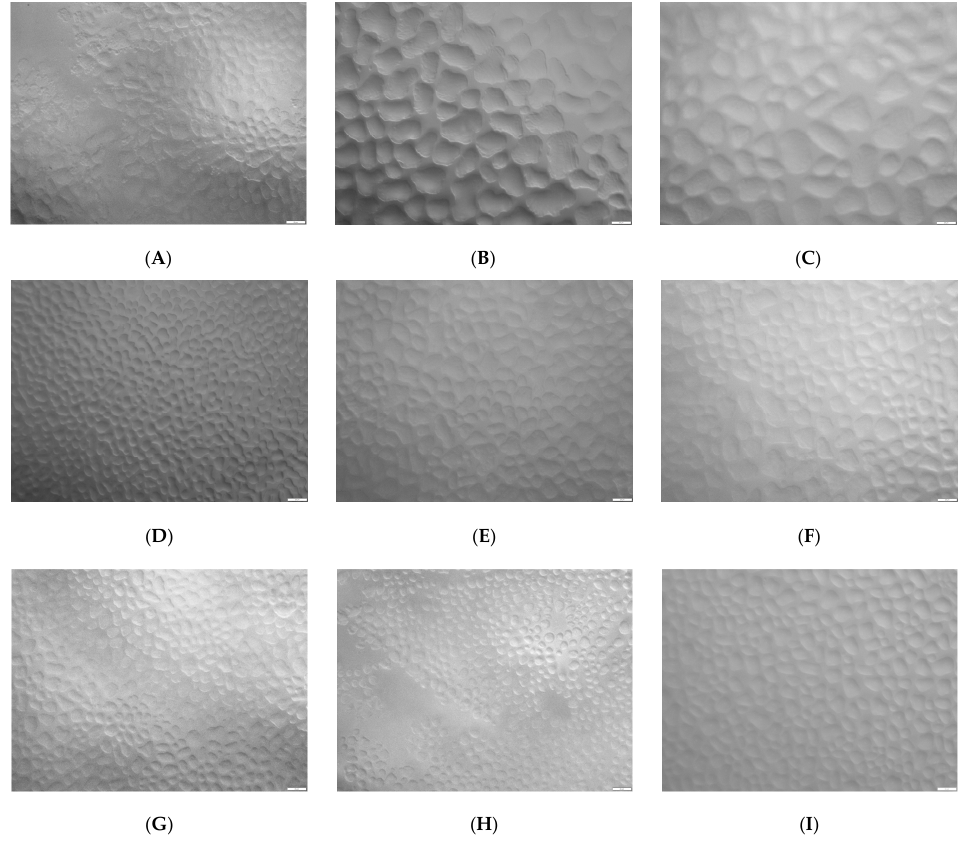
Figure 6. Microscopic images of ice crystals in low ‐ fat milky ice cream with and without stabilizers after different times of storage (( A , D , G ) 24 h, ( B , E , H ) 1 week (1 W) and ( C , F , I ) 1 month (1 M)): ( A – C ) low ‐ fat milky ice cream without stabilizer (control); ( D – F ) low ‐ fat milky ice cream with 0.5% of Cremodan ® SI 320; ( G – I ) low ‐ fat milky ice cream with 0.5% of oat β‐ glucan. Small ice crystals ranging in size to 20 μ m of equivalent diameter give the product desired smoothness, while ice crystals larger than 50 μ m give the product an undesirable lumpy texture [6,7,39,40]. Probably milk protein with the combination of β‐ glucan creates the favorable structure with the best water ‐ holding capacity resulting in better crystal structure creation. The β‐ glucan addition probably also changes the heating exchange con ‐ ditions during ice cream production, which was also visible in the lower value of cryo ‐ scopic temperature in comparison to the cryoscopic temperature of the control sample (Table 3). Similar correlation was already shown for the ice cream stabilizer’s addition [41]. It was also proved that a polysaccharide addition could lead to growth of the crystals different from hexagonal [10]. The hexagonal structure is more favorable for binding plenty of water molecules [42]. Table 3. Cryoscopic temperature and osmolality of milky ice cream. Sample